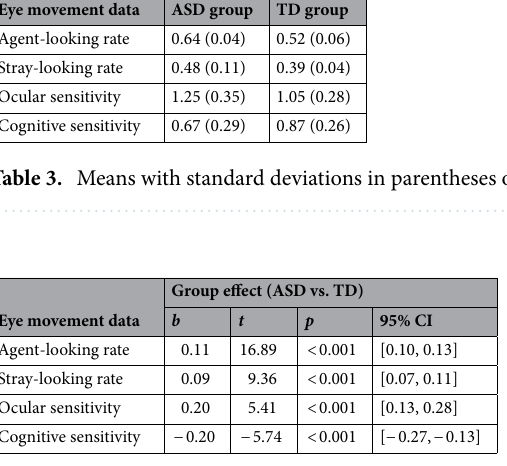
Table 4. Fixed effect estimates of eye movement measures for the two groups. CI Confidence Interval.